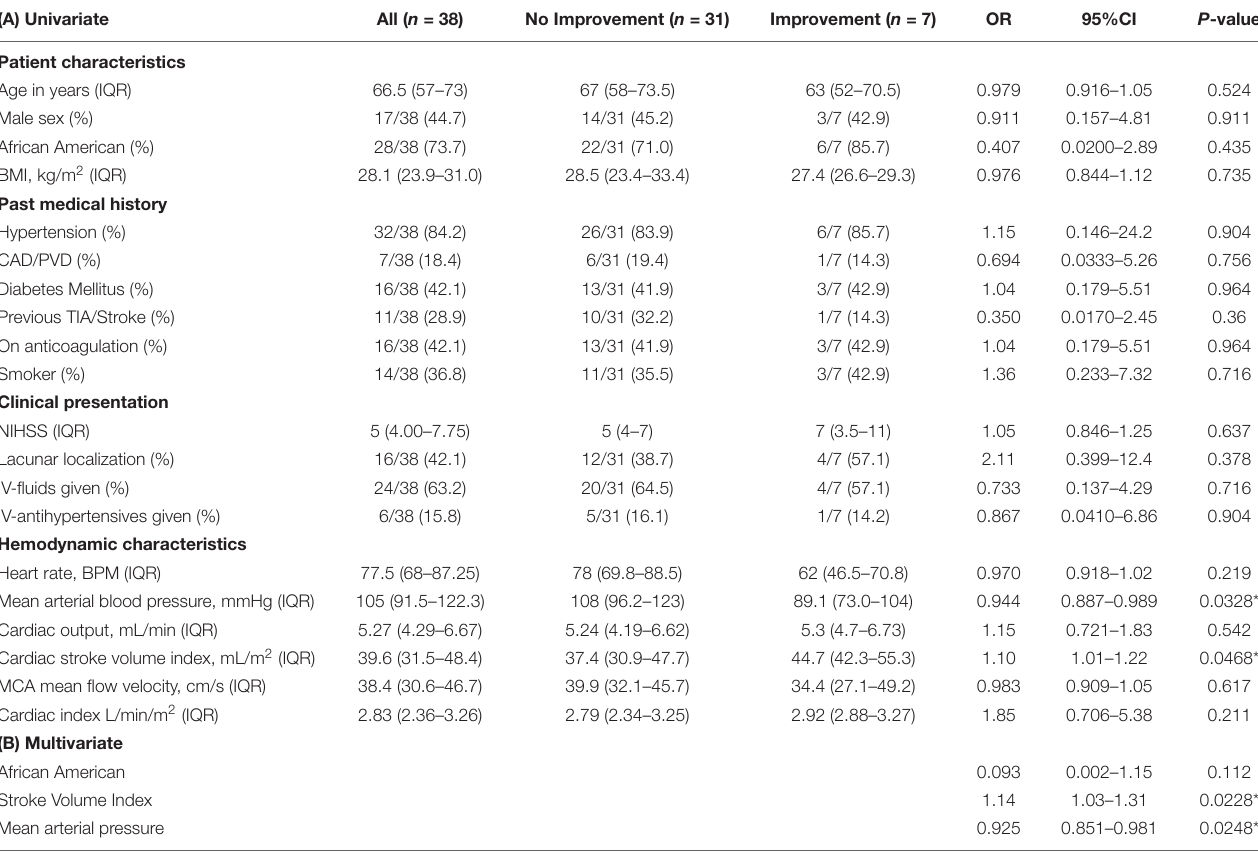
TABLE 1 | Patient demographic, clinical, and hemodynamic data with univariate and multivariate results. (A)